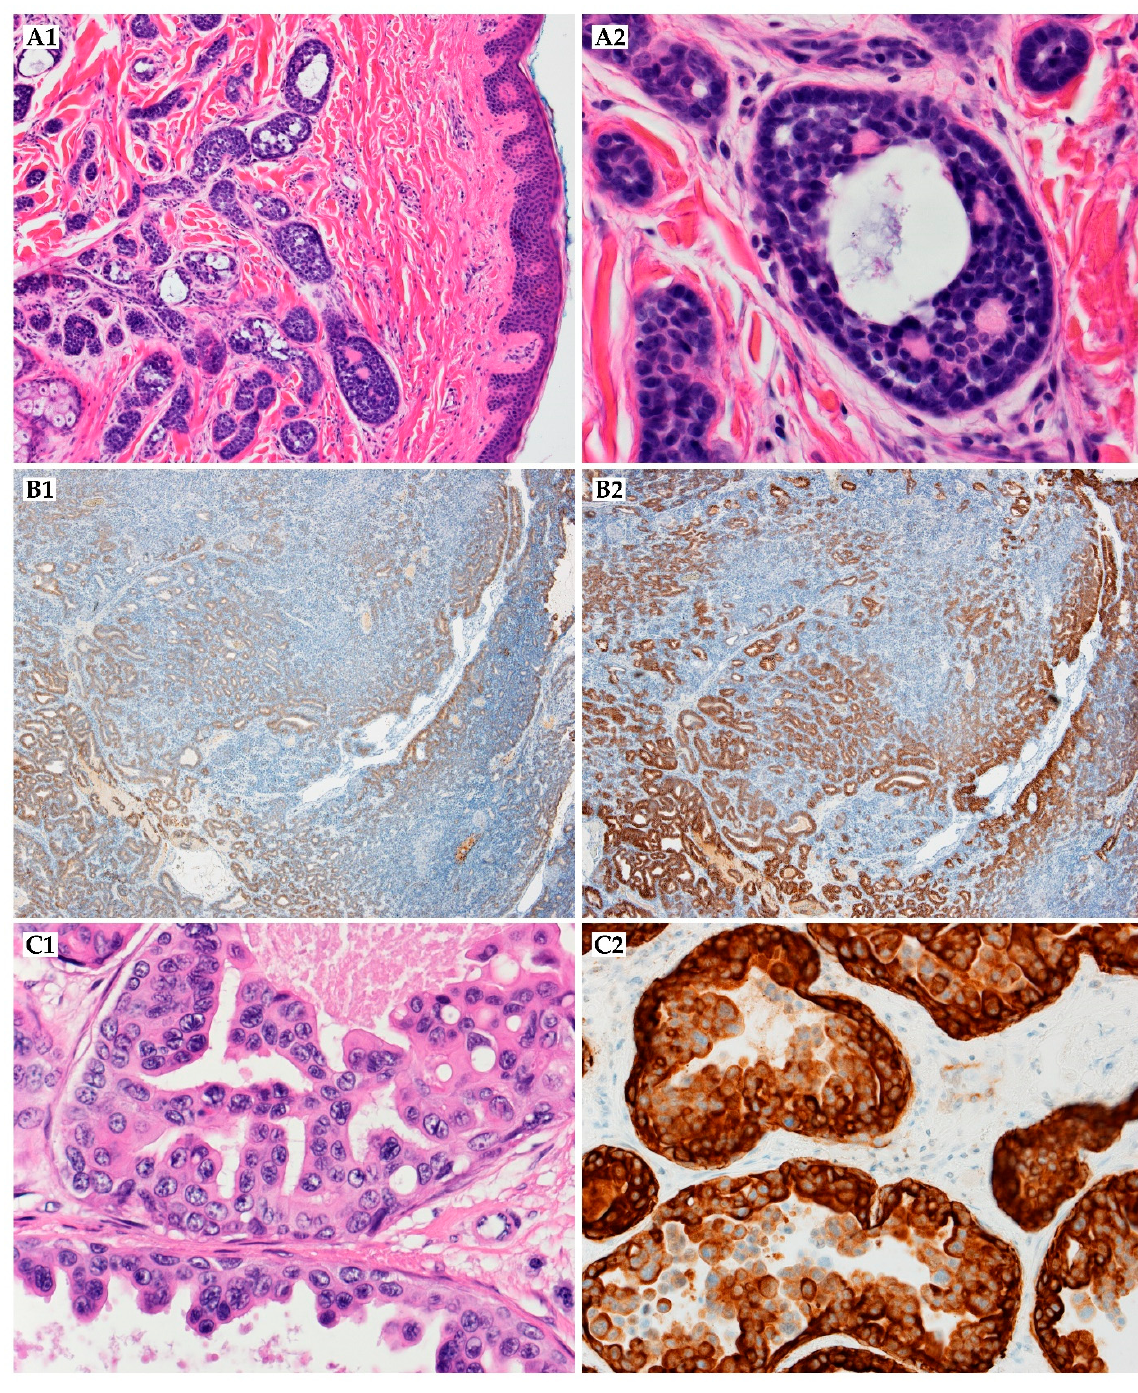
Figure 6. Malignant tumors with apocrine or eccrine differentiation II. ( A1 ) (20×, HE) and ( A2 ) (400×, HE): Adenoid cystic carcinoma, the coexistence of small bi-layered ducts and pseudocysts. ( B1 ) (20×, S100) and ( B2 ) (20×, CK7): Digital papillary adenocarcinoma with multinodular growth, cystic, papillary, and glandular structures showing diffuse expression of S100 (in both luminal and myoepithelial cells) and CK7 (highlights the luminal borders). ( C1 ) (400×, HE) and ( C2 ) (400×, CK5/6): Apocrine carcinoma, neoplastic cells with abundant eosinophilic cytoplasm with a strong and diffuse expression of CK5/6 which favors primary skin